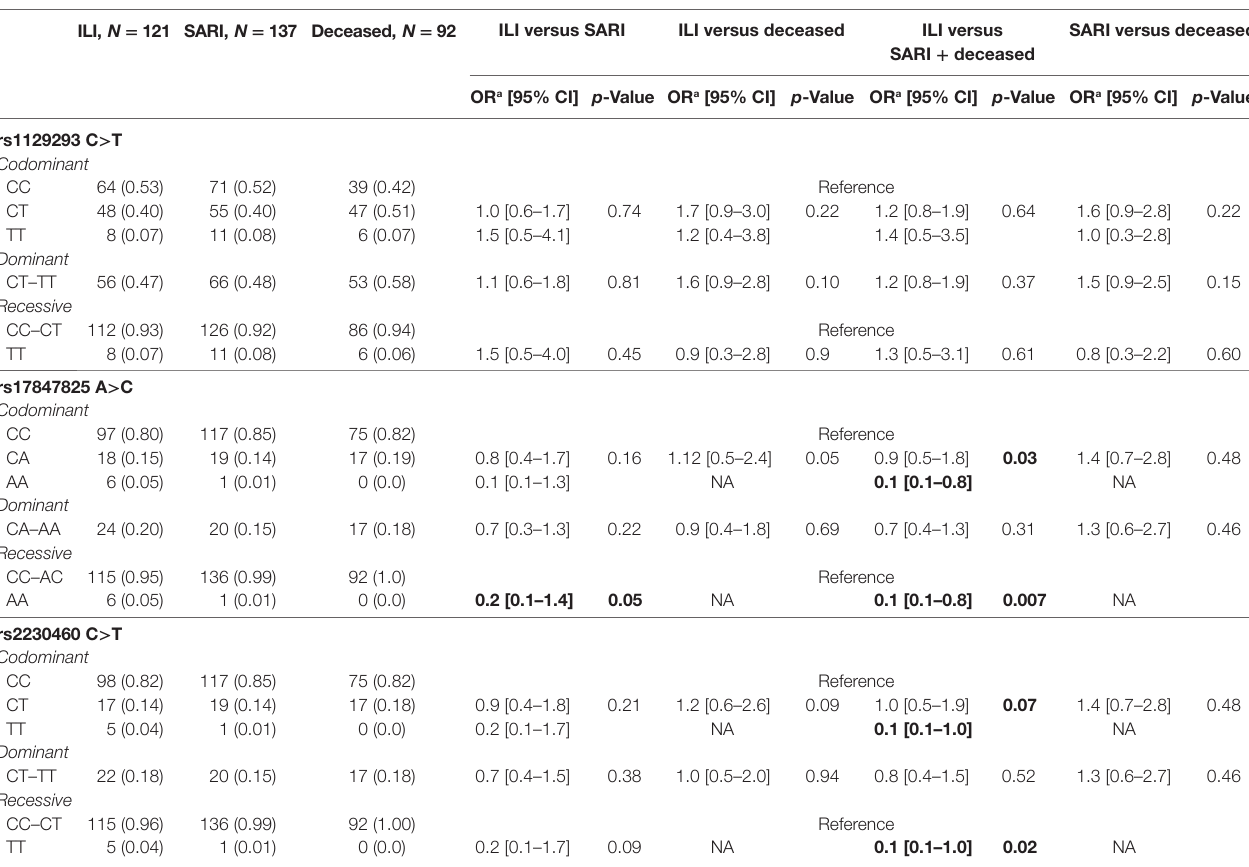
TaBle 3 | Analysis of SNPs located in PIK3CG.